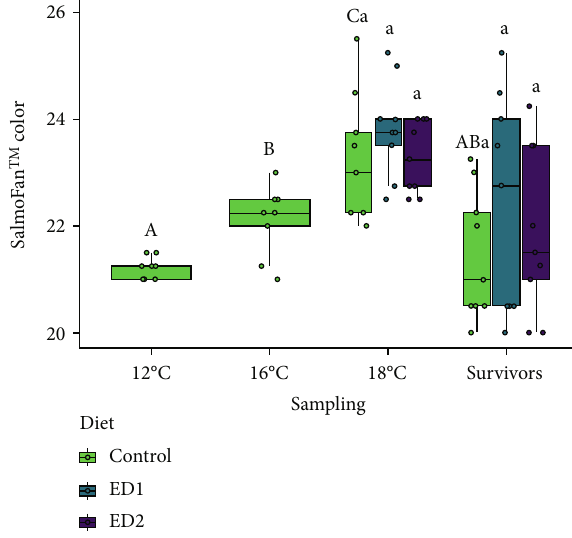
Figure 2: SalmoFan ™ fi llet colour scores over the course of the study ( n = 9 per each sampling/dietary treatment). Upper case letters denote signi fi cant ( p < 0 : 05 ) di ff erences between samplings within the control treatment. Lower case letters indicate that no di ff erences were detected among dietary treatments within a sampling. There was no di ff erence in the colour scores in fi sh fed experimental diet # 1 (ED1) and # 2 (ED2) between